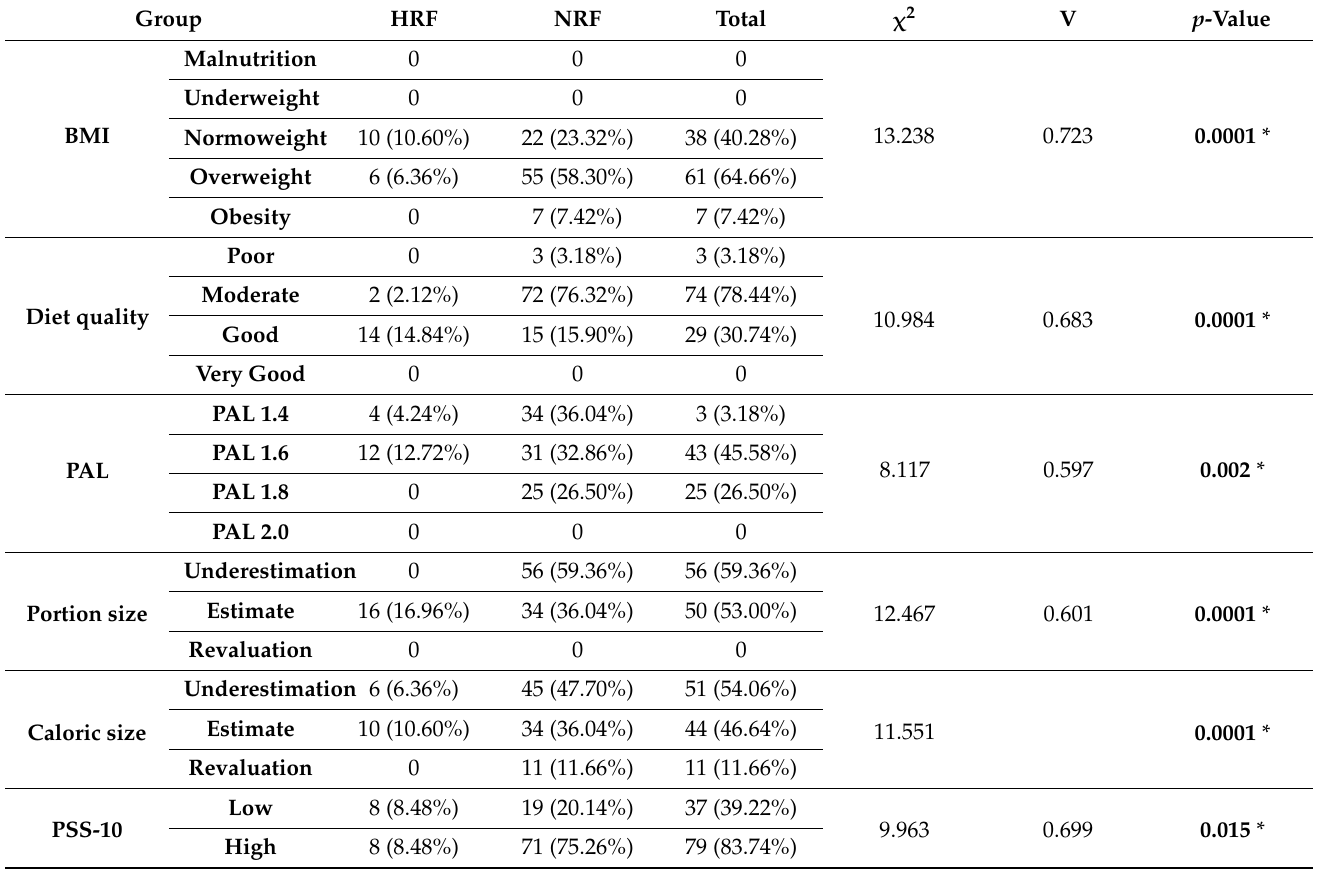
Table 3. Scores of subscales on emotional eating by selected indicators (N = 106; HRF = 16; NRF =